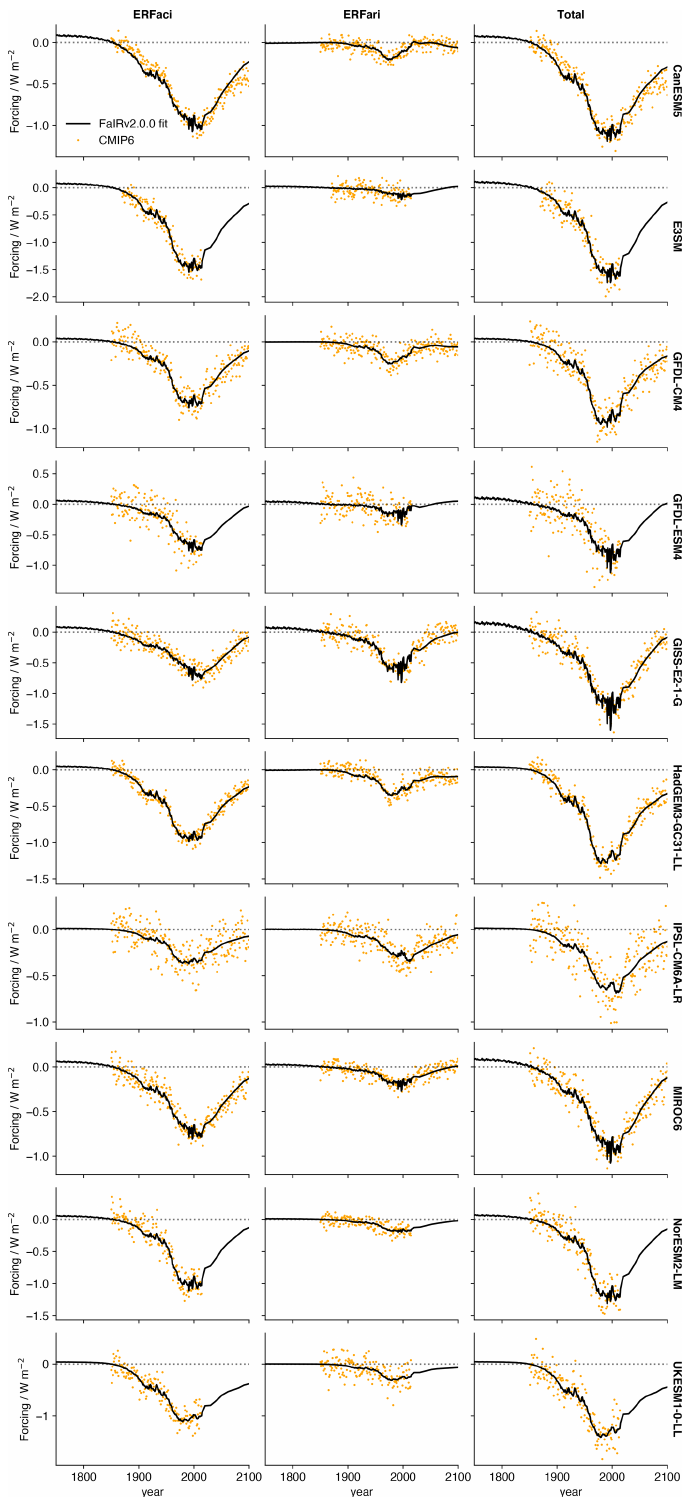
Figure 5. FaIRv2.0.0 emulation of CMIP6 model aerosol forcing. The black line shows FaIRv2.0.0-alpha emulation, and the orange dots show CMIP6 model data. All series displayed are relative to zero effective radiative forcing in